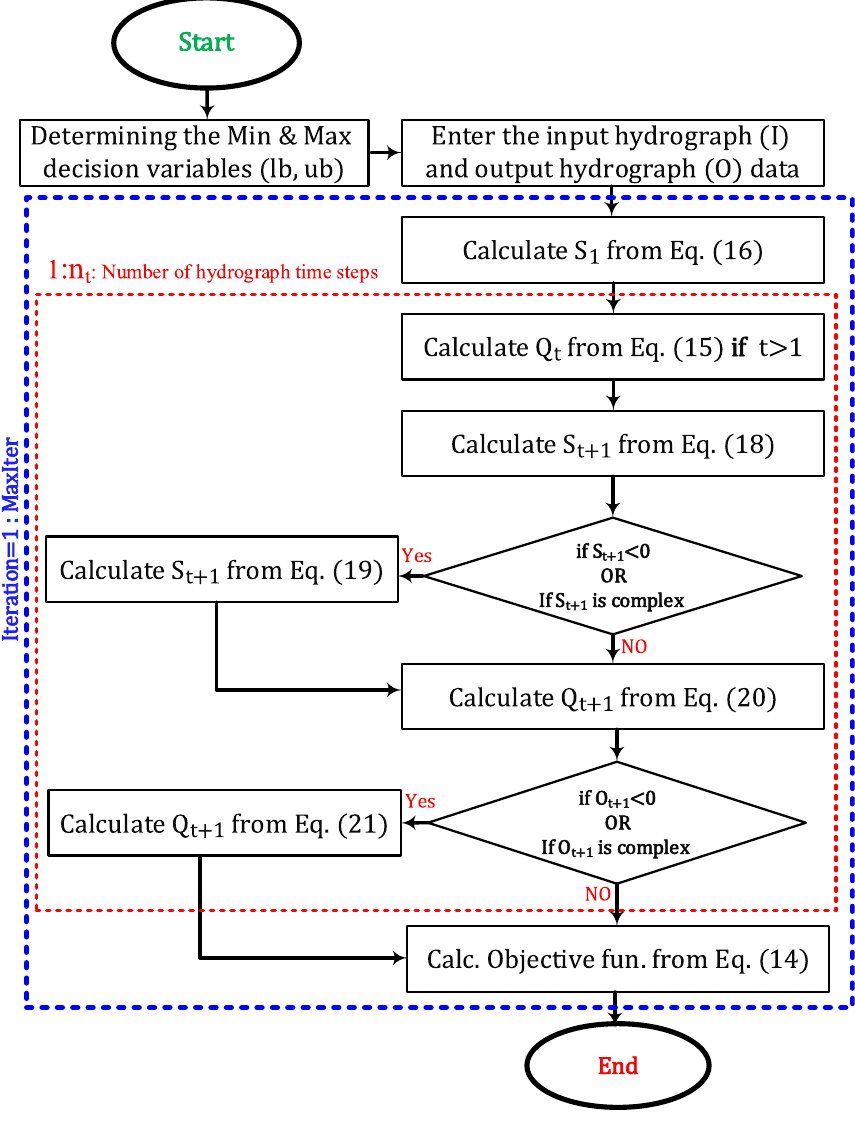
Fig. 1 Flowchart of